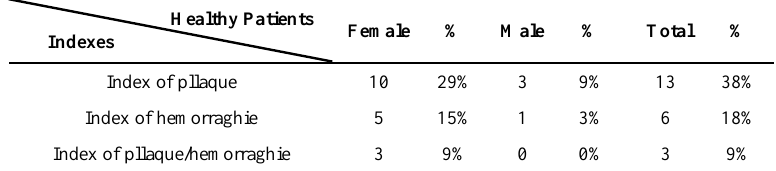
Table 5. Gender-healthy patient data, based on periodontal indices, for the first group of patients